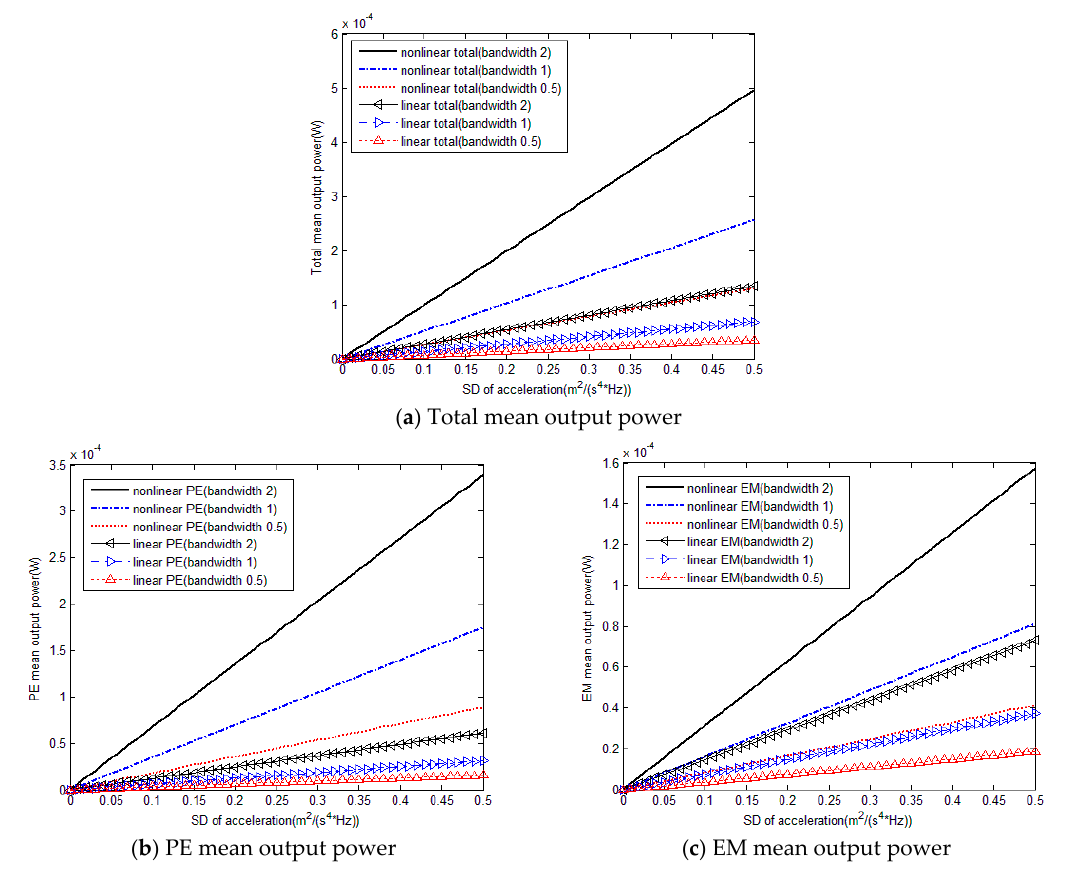
Figure 10. Total mean output power of hybrid energy harvester with load resistances under different bandwidths.